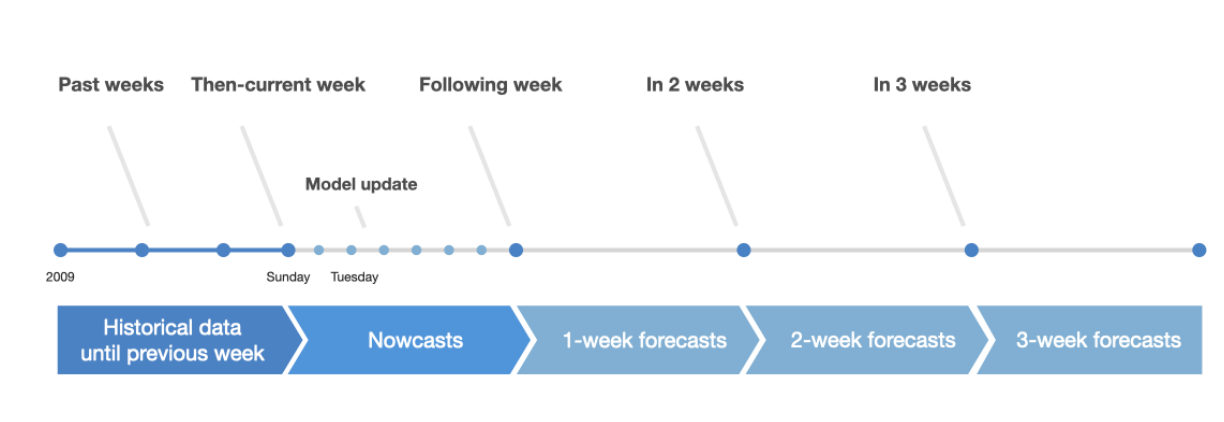
Figure 1. Timeline of historical data used for model training and forecasting